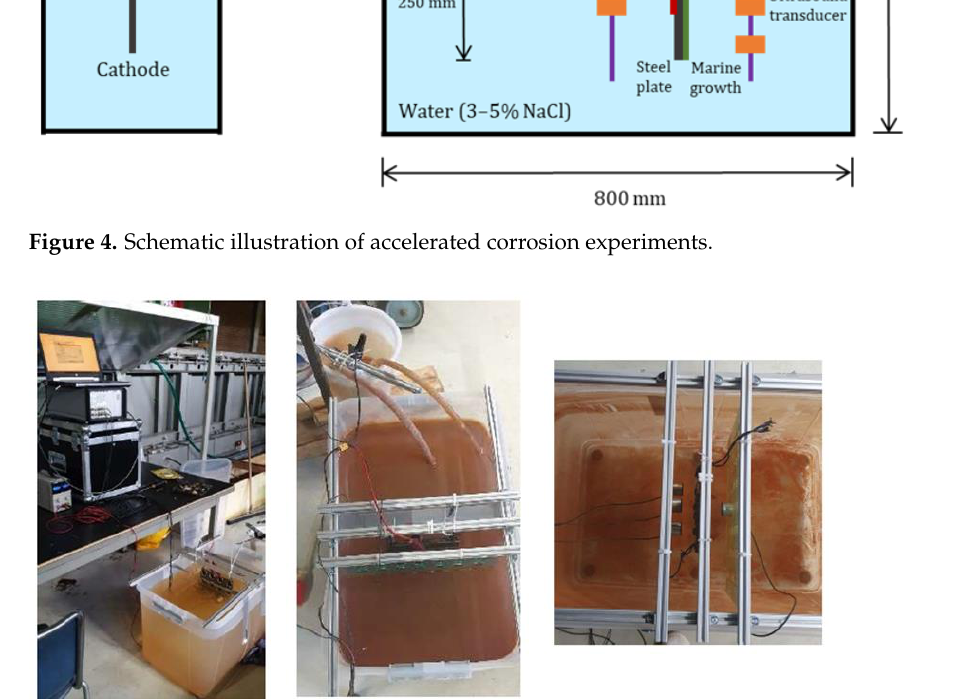
Figure 5. Accelerated corrosion experiments